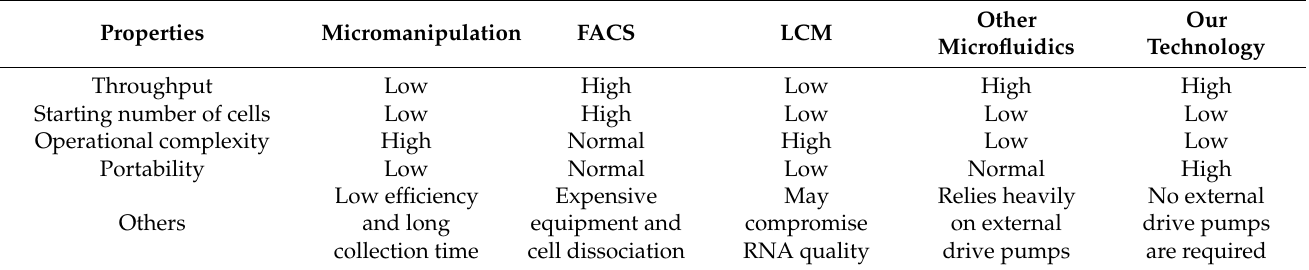
Table 1. Comparison of various techniques for single-cell isolation